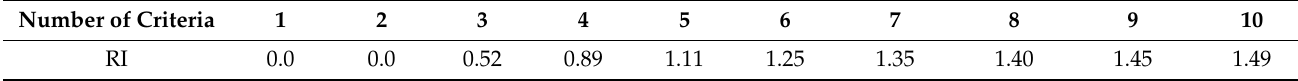
Table 8. Random Index (RI)